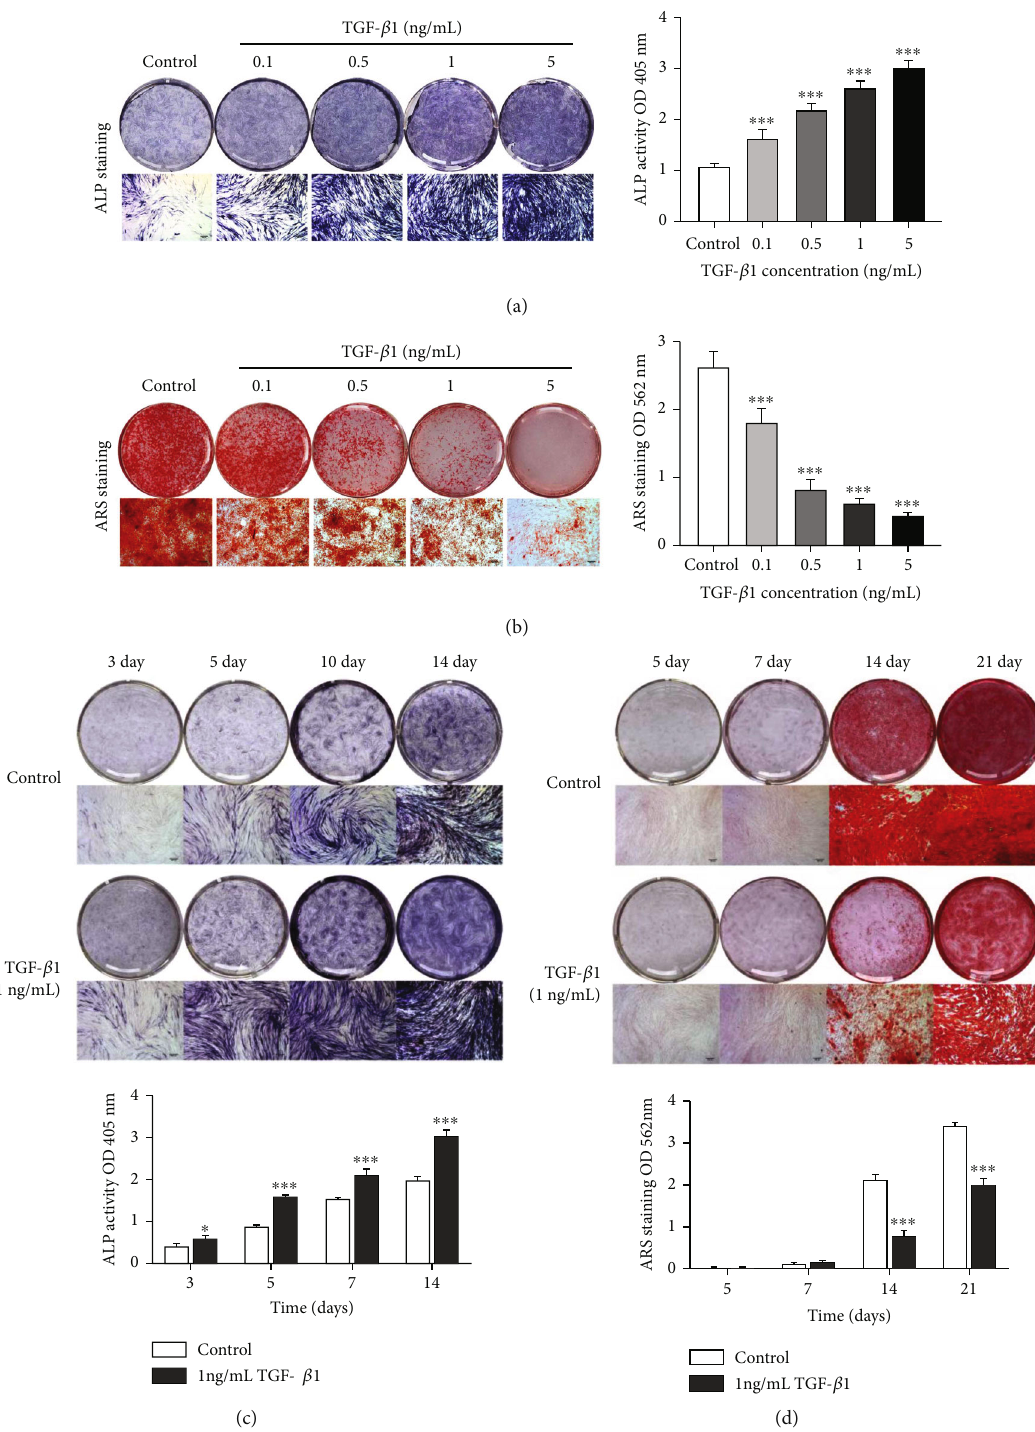
Figure 3: E ff ect of TGF- β 1 on odontogenic di ff erentiation of DPSCs in vitro (a) Images of ALP staining and ALP activity of DPSCs following range of concentrations of TGF- β 1 (0-5ng/mL) exposure for 7 days (50 × ). (b) Images and quantitative measurement of calcium mineral deposition stained by ARS staining in DPSCs cultured with the TGF- β 1 concentrations for 14 days (50 × ). (c) Images of ALP staining and ALP activity of cells incubated with 1ng/mL TGF- β 1 at a range of time-points (days 3, 5, 10, 14) (50 × ). (d) Images and quantitative measurement of calcium mineral deposition stained by ARS staining in DPSCs following 1ng/mL TGF- β 1 exposure at di ff erent time-points (days 5, 7, 14, 21) (50 × ). Error bars = means ± standard deviation (SD), n = 3 , statistically signi fi cant di ff erence at the levels ∗ p < 0 : 05 and ∗∗∗ p < 0 : 001 (ANOVA) compared with the control group. ALP: alkaline phosphatase; ARS: Alizarin Red S; DPSCs: dental pulp stem cells; TGF- β 1: transforming growth factor- β